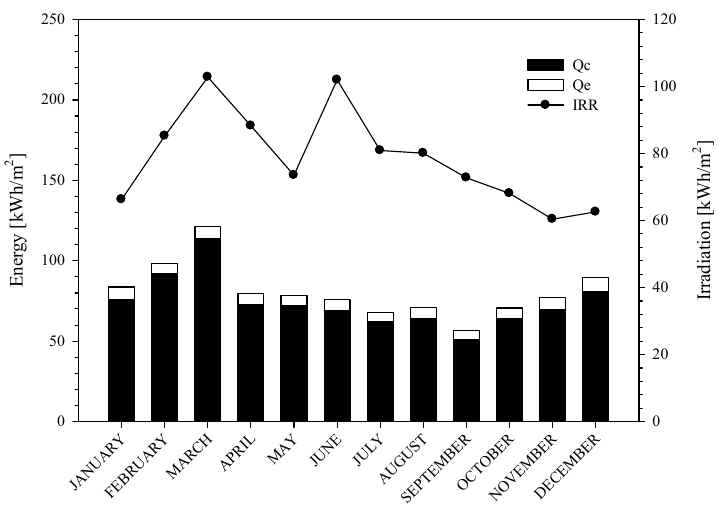
Figure 11. Energy production of mc-Si PVT collector.